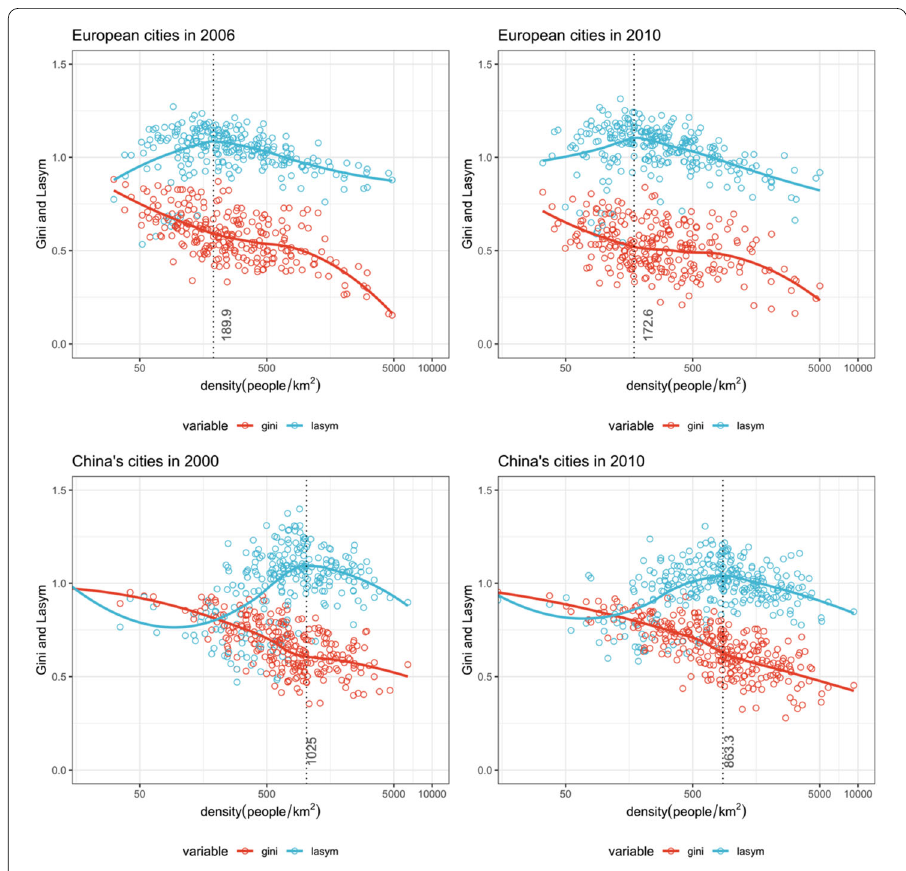
Figure 2 Gini and Lasym indices over population density. The blue points represent Lasym, and the red points represent Gini. The regression curve is computed using a piecewise polynomial regression model, and the dashed line indicates the density level where peaks of the regression curve occur